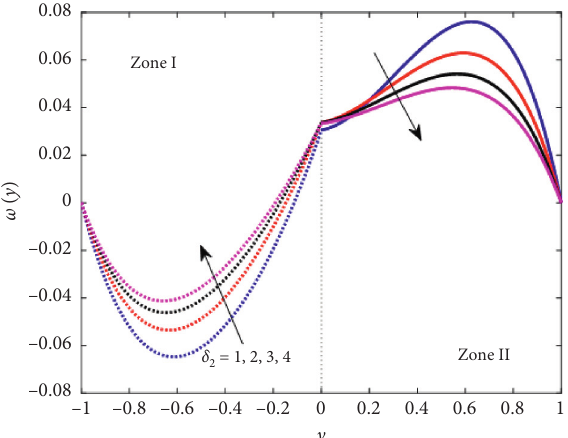
Figure 10: Microrotation profiles for various δ